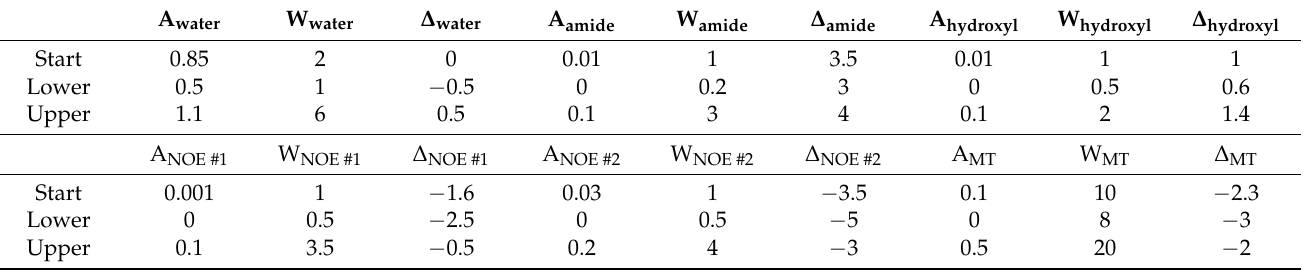
Table 4. Starting points and boundaries of the amplitude (A), width (W), and offset ( ∆ ) of the six-pool Lorentzian fit, which we used for our in silico, in situ, and in vivo studies of IVDs. Furthermore, we used a custom loss function (Equation